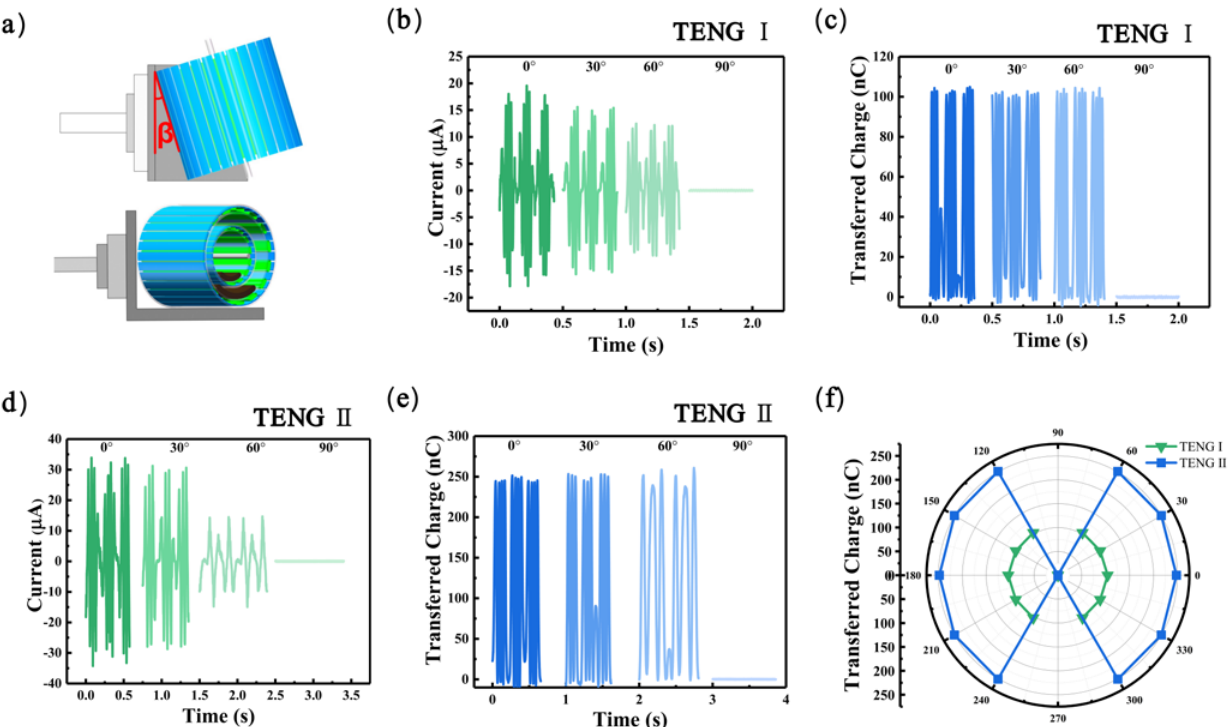
Figure 4. Electrical output performance of MC-TENG with different excitation directions. ( a ) The fixed position of MC-TENG on the linear motor. ( b , c ) The short-circuit current values and the corresponding transferred charges for different deflection angles of TENG I with a fixed amplitude of A = 25 mm and f = 4 Hz. ( d , e ) The short-circuit current values and the corresponding transferred charge at different deflection angles of TENG II with fixed amplitude of A = 25 mm and f = 2.25 Hz. ( f ) Transfer charge simulated by TENG from different angles.